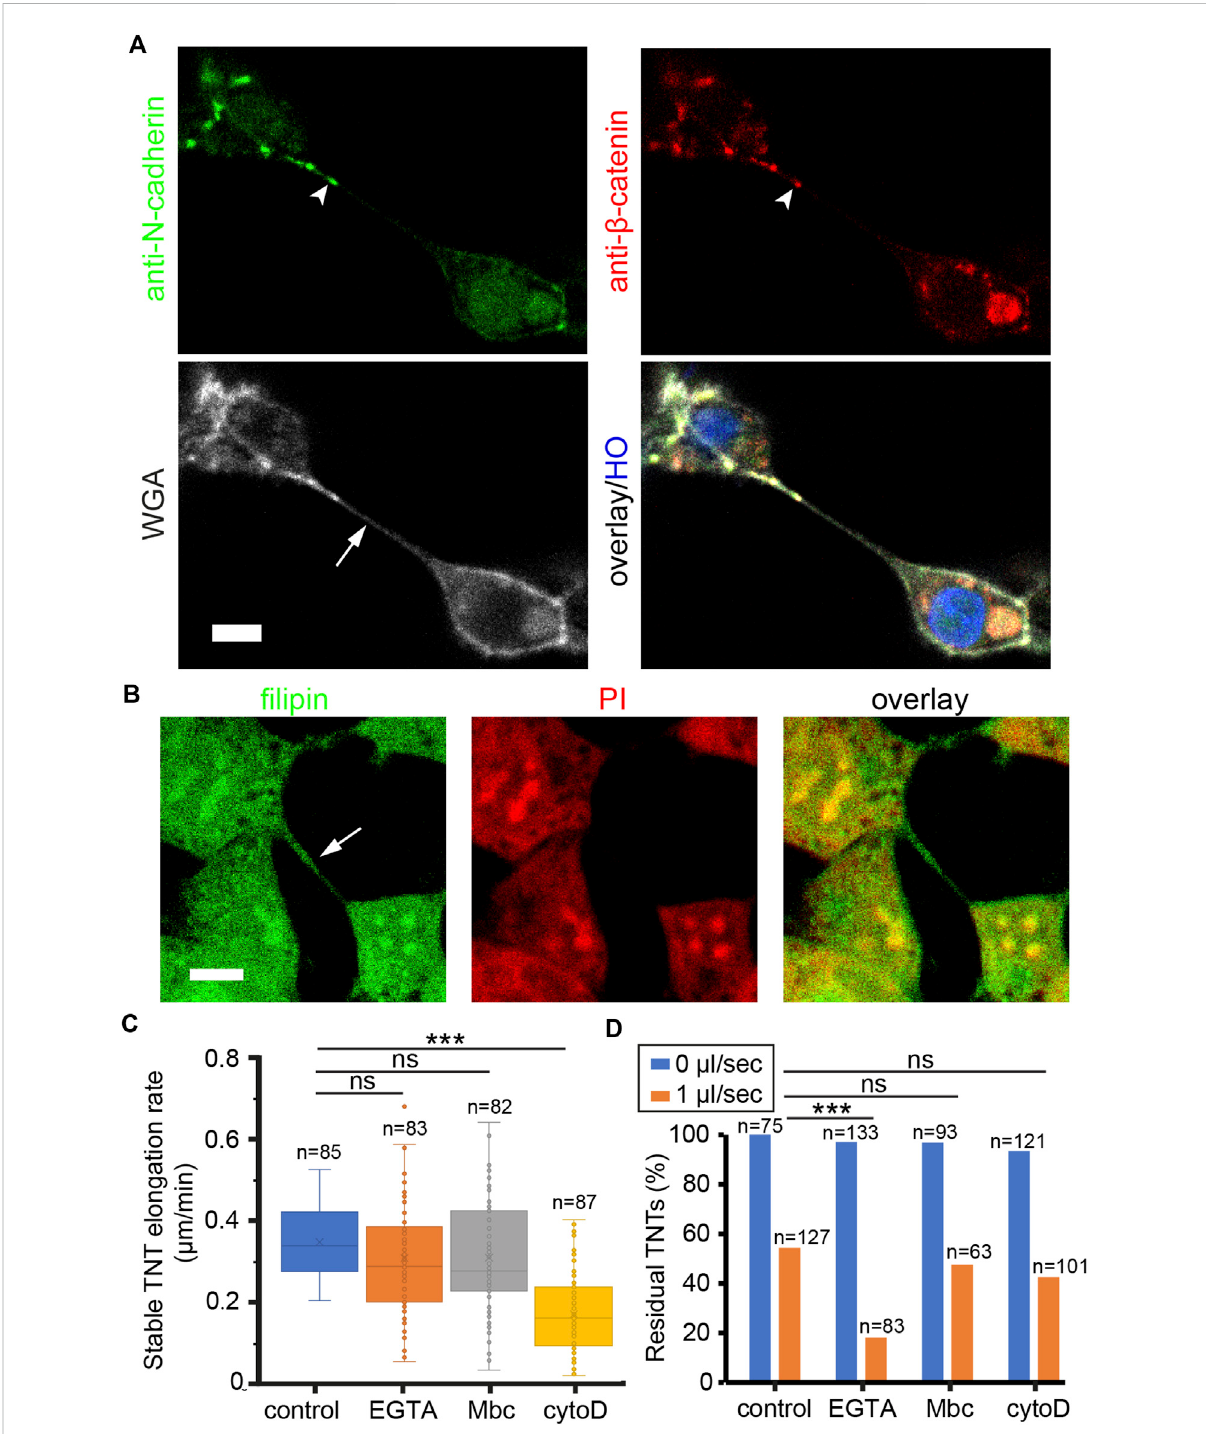
FIGURE 4 Molecular components of TNTs regulate their mechanical stability. (A) Co-localization of N-cadherin and β -catenin (arrowheads) at the tip of TNT. TNT (arrow) was stained with WGA-AF633. Nucleus were labeled by HO. (B) Cholesterol on TNT (arrow) and plasma membrane was stained by fi lipin. Nucleus were labeled by PI. (C) Effect of drugs on the elongation rate of stable TNTs. (D) Effect of drugs on the number of TNTs in static and fl ow stress (1 μ l/s) conditions. Scale bars, 10 μ m.